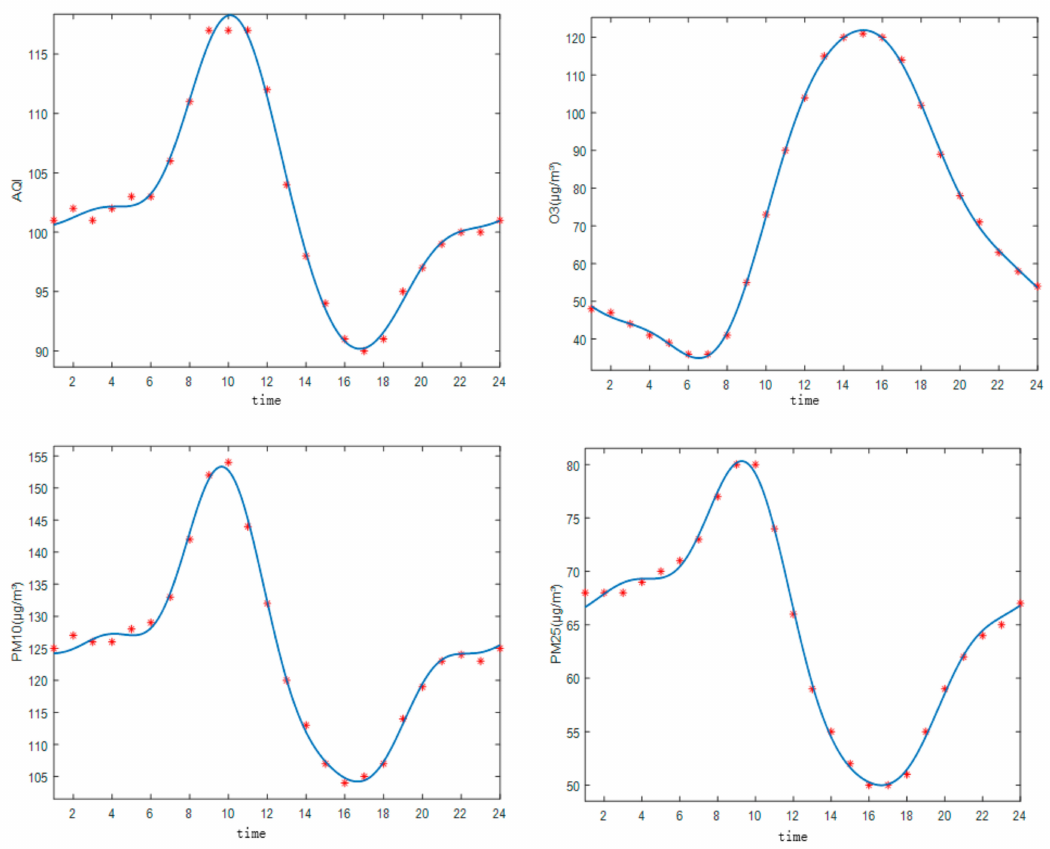
Figure 9. Fitting curves of the AQI and major pollutant